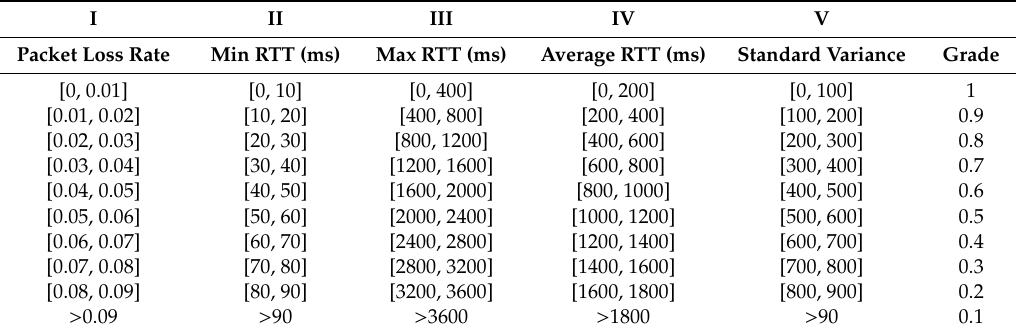
Table 6. Performance metrics of the DBTRN. RTT: Round-Trip